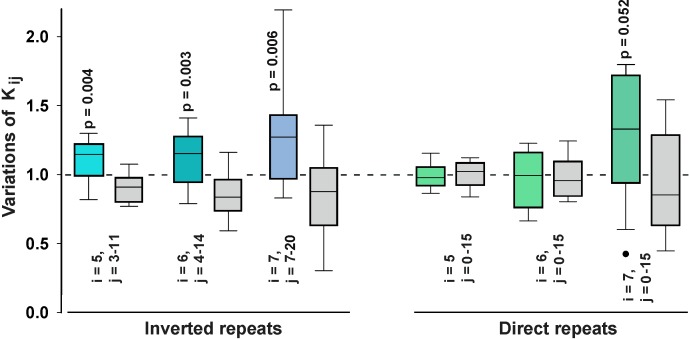
Dps-binding sites are enriched with inverted repeats.The overlap between sequences of CS (colored box-plots) and UR (gray boxes) with direct or inverted repeats was characterized by the parameter Kij as described in the text. Black dot on the right panel shows one outlier. Box-plots with statistically significant differences are provided with corresponding p-values. Regions of bound and unbound sets overlapping with repeated sequences of both types are indicated in S3 Table.